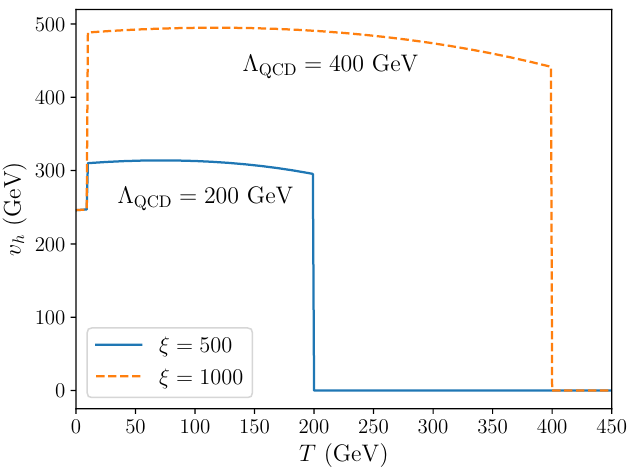
Figure 3 . Higgs VEV as a function of temperature T for (cid:24) = 500 ; 1000 and T d = 10 GeV. The sudden changes occur at T ’ (cid:3) QCD and T d